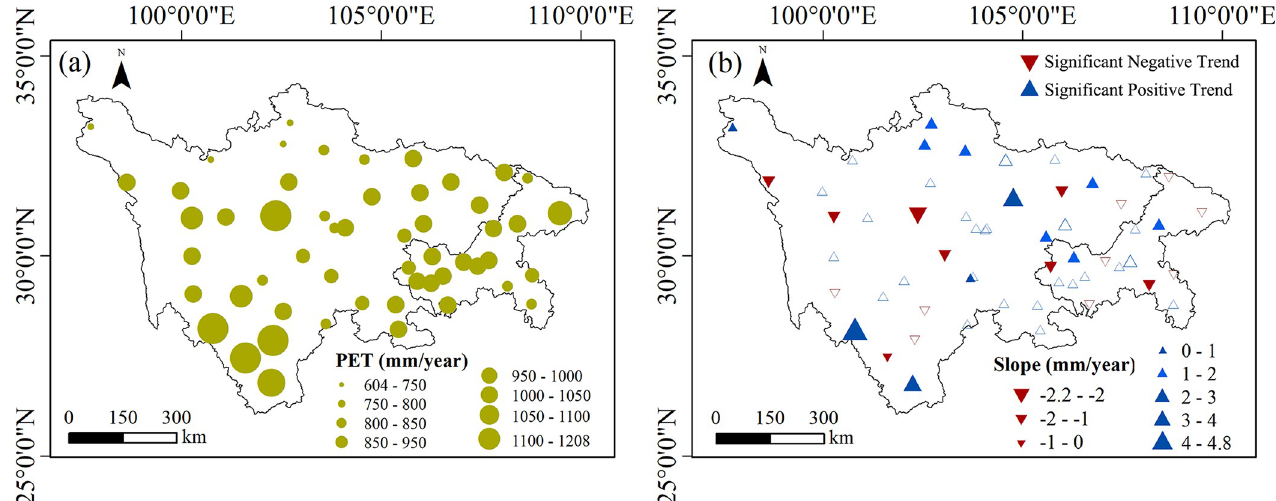
Fig 3. Spatial distributions of (a) mean annual PET, and (b) its trends slopes and the MK test results ( p < 0.05) in the Sichuan-Chongqing region for 1970– 2020. Blue upward and red downward triangles represent positive and negative trends, respectively. Solid triangles indicate trends are statistically significant ( p < 0.05).